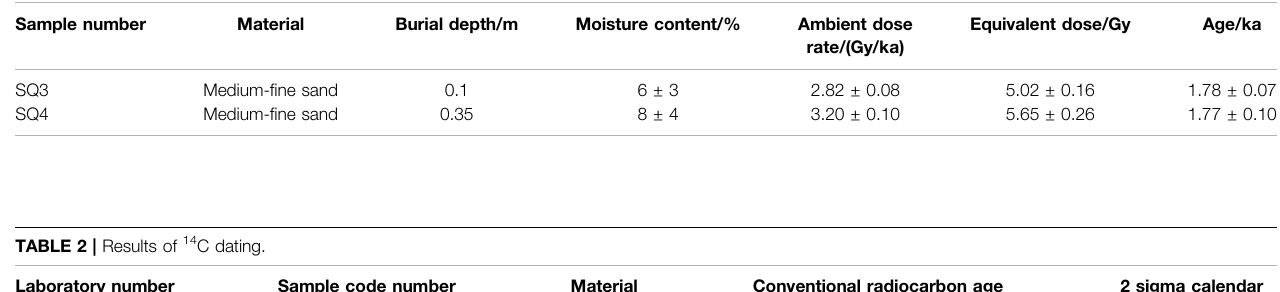
TABLE 2 | Results of 14 C dating.